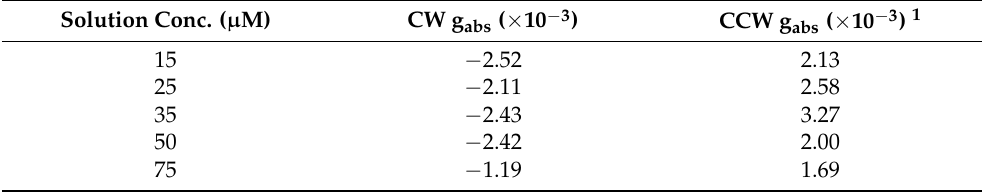
Table 1. The dissymmetry-factor dependence as function of the solution concentration measured